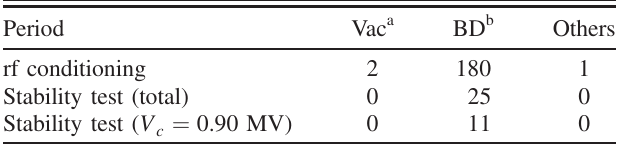
TABLE II. Classification and number of cavity trip events.